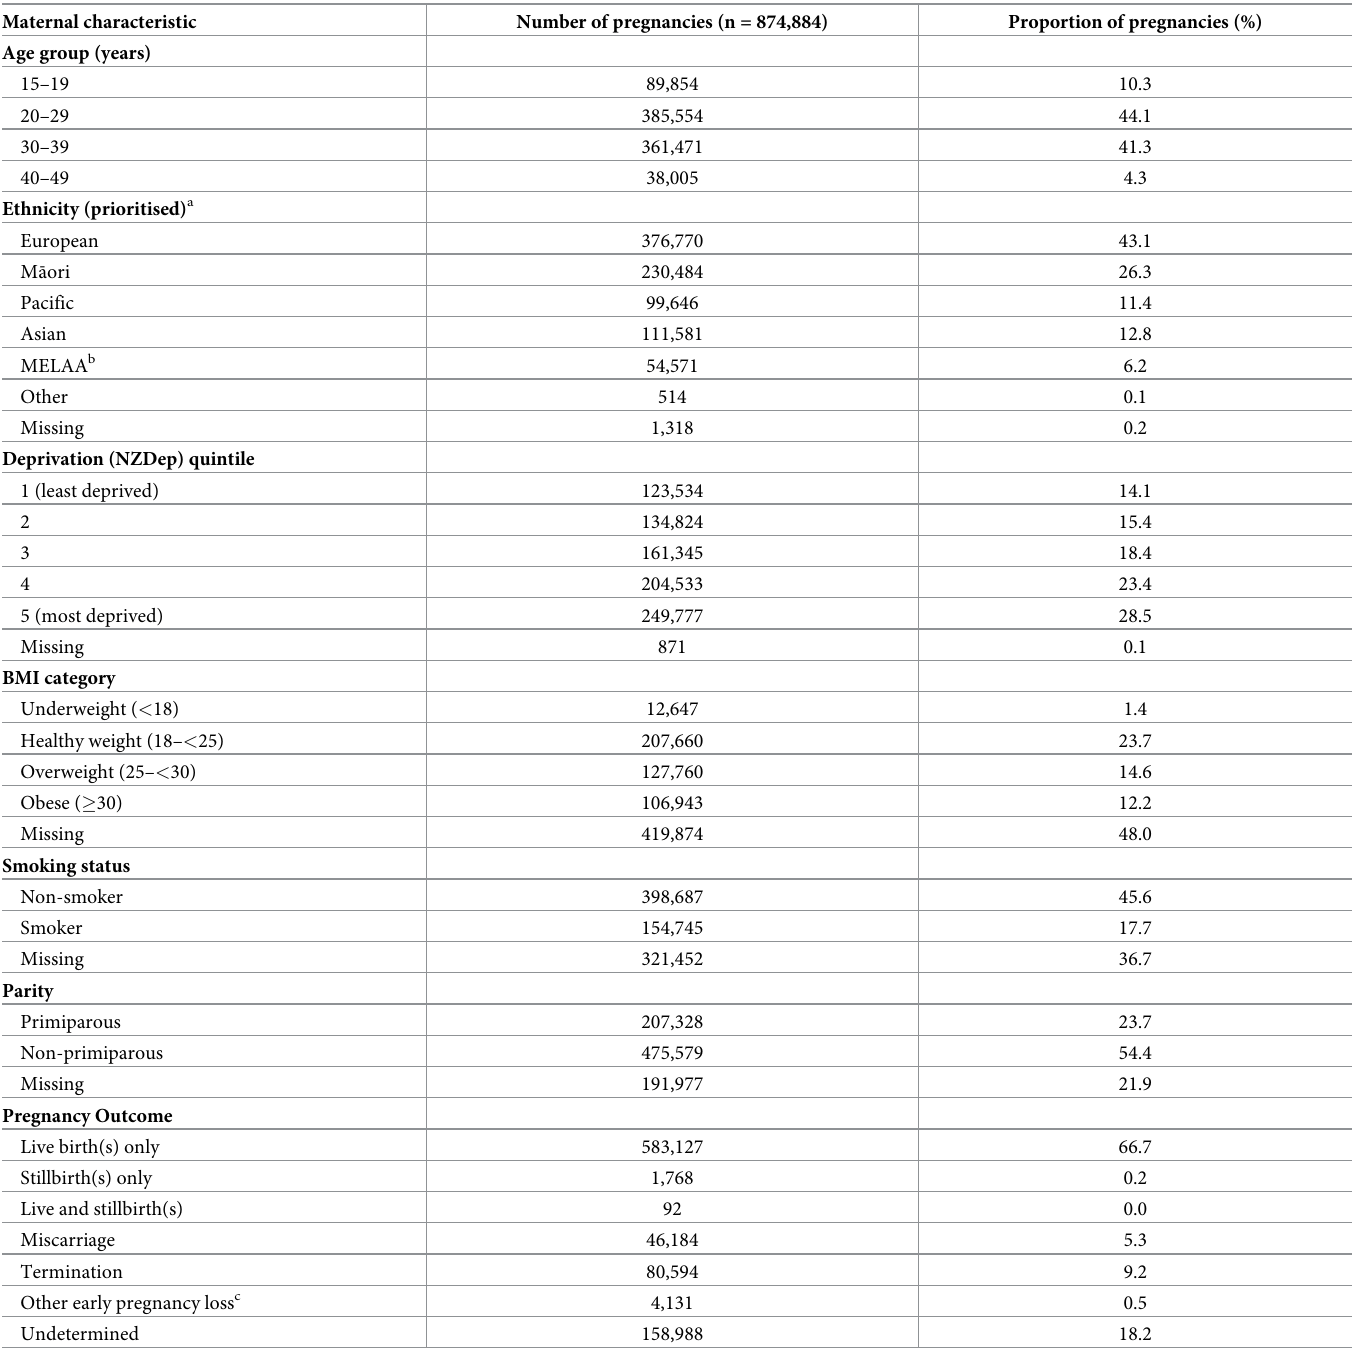
Table 1. Maternal characteristics at the time of pregnancy and pregnancy